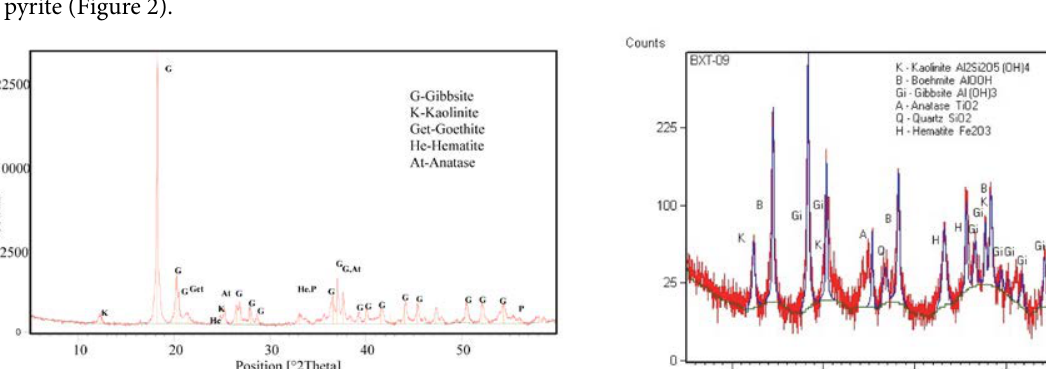
Figure 4. Diffractogram of the standard bauxite sample NBS 698 (Jamaican) – Standard BXT 09 is a combined gibbsite-boehmite type of bauxite with hematite content. In addition to those